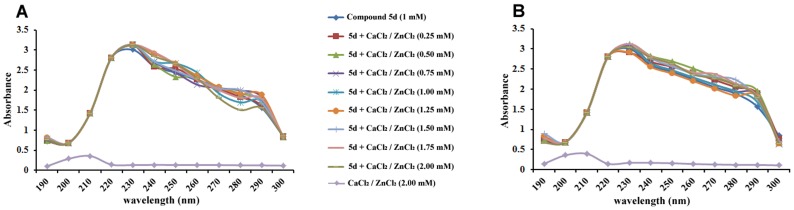
UV-VIS spectral studies of compound 5d in presence of CaCl2 and ZnCl2.The mixture of compound 5d (1 mM) and different concentrations of (A) CaCl2 and (B) ZnCl2 (0–2.0 mM) in a final volume of 1 mL PBS. The samples were monitored by spectroscopic scanning with the wavelength range of 200 to 300 nm.